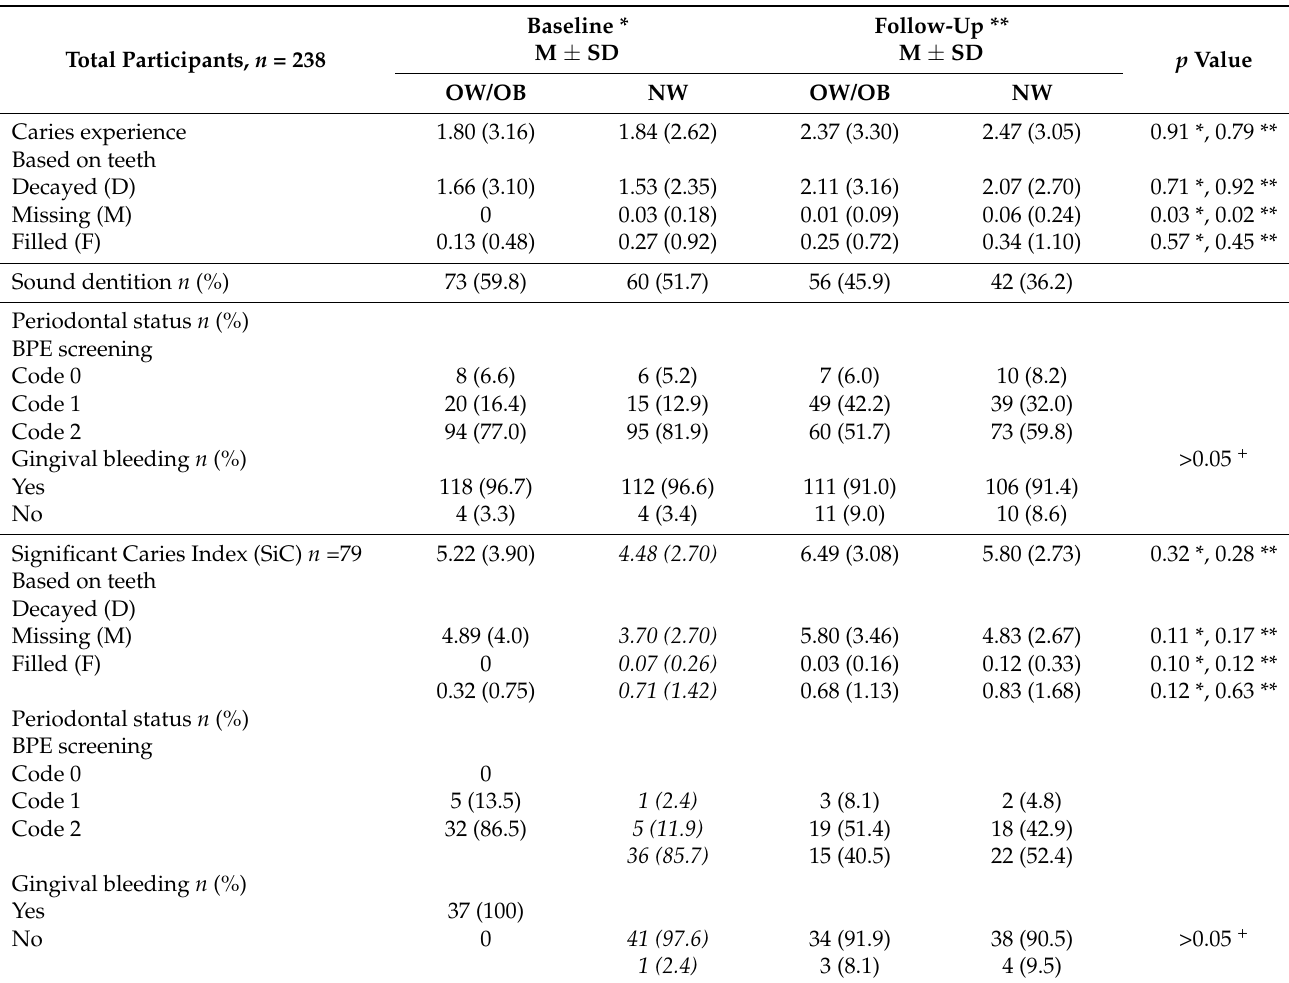
Table 3. Oral health status in obese and normal weight groups of total participants and SiC group at baseline and follow-up.